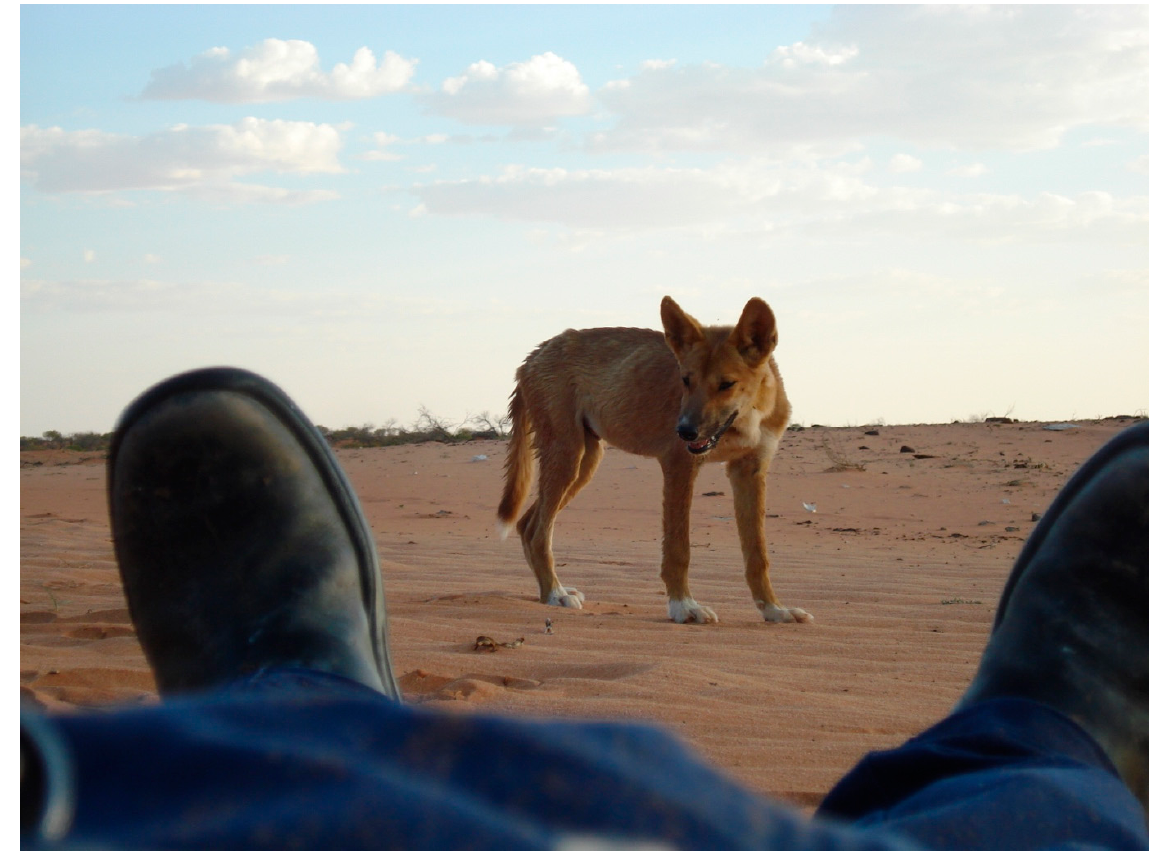
Figure 5. A wild dingo approaching a human seemingly out of curiosity. This behaviour is observed in isolated populations of dingoes that have had no prior interaction with humans. This juvenile dingo was encountered in December 2009 on Quinyambie Station (north-east South Australia) in the Strzelecki Desert. Credit: Benjamin